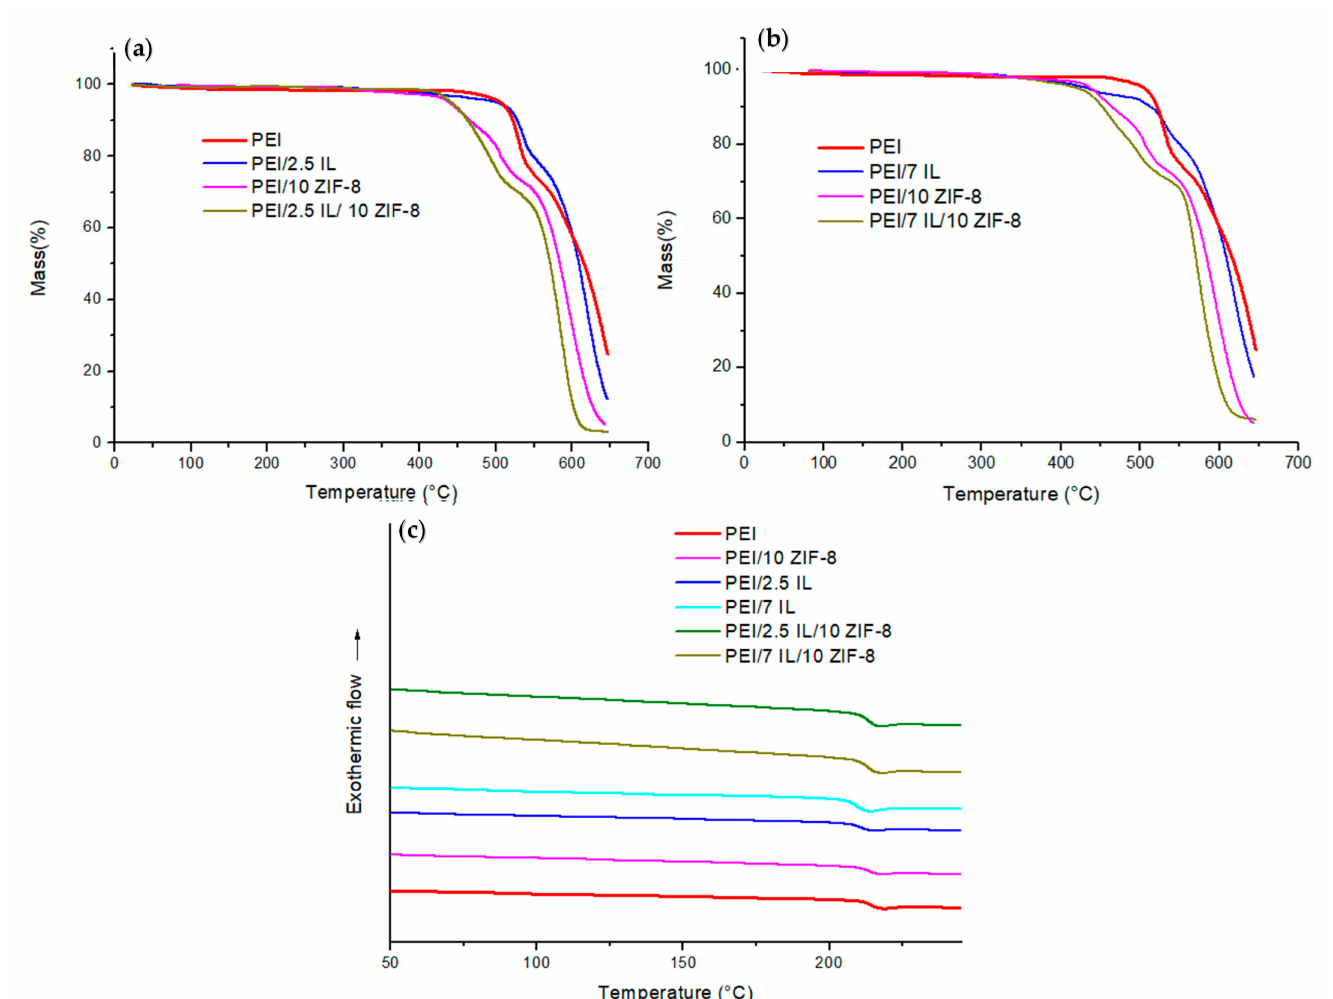
Figure 10. ( a , b ) TGA and ( c ) DSC plots of the studied